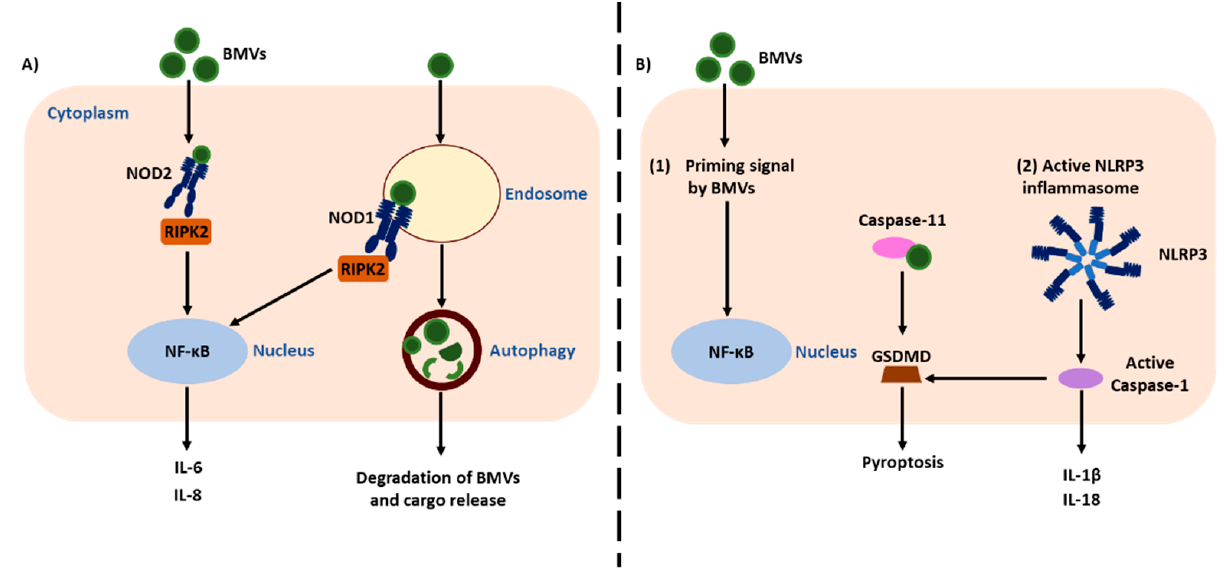
Figure 2. Activation of NLRs by BMVs in host cells. BMVs can enter host cells using a number of mechanisms, whereby access to NOD-like receptors (NLRs) occurs. ( A ) Internalised BMVs interact with NOD1 and NOD2, which can lead to endosomal localisation of NOD1, NF-kB activation and the production of proinflammatory cytokines. Furthermore, once intracellular, BMVs can be degraded by the host cellular degradation pathway of autophagy in a NOD1-dependent manner. ( B ) BMVs can also prime host cells for NLRP3 inflammasome activation, which leads to cleavage of GSDMD, pyroptosis and the production of proinflammatory cytokines. BMVs have also been shown to interact with caspase-11, inducing inflammasome activation and the release of proinflammatory cytokines.